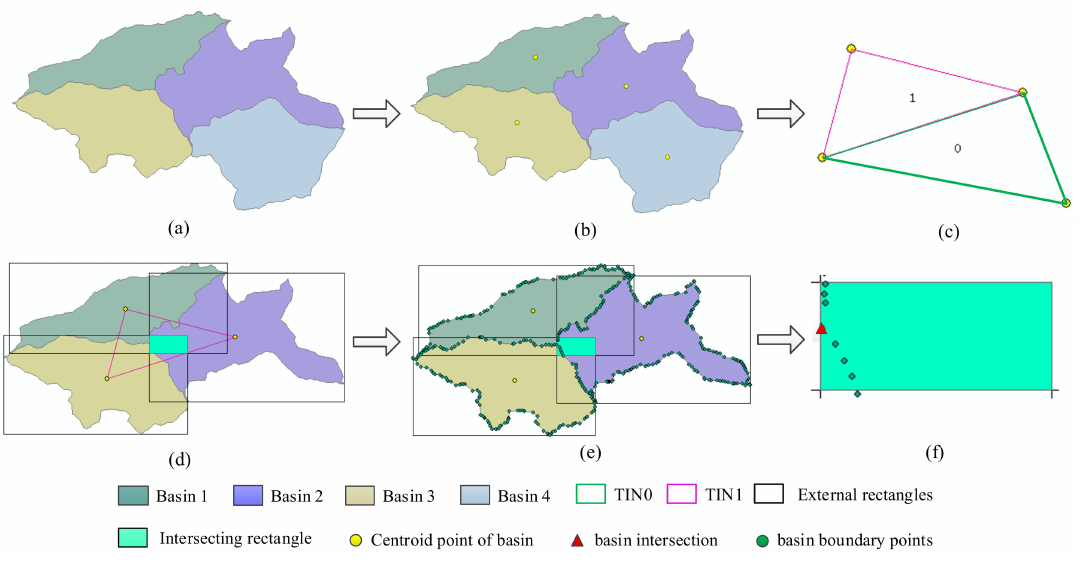
Figure 6. Extraction process of basin intersections. ( a ) Initial basins. ( b ) Regional adjacency graph. ( c ) D-TIN. ( d ) External rectangles and intersecting rectangle. ( e ) The points of the basin boundaries within the intersecting rectangle. ( f ) The basin intersection.